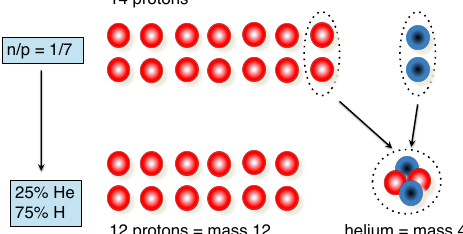
Figure 1: Left: The observed nearly 25% of helium and 75% of hydrogen in the universe can be understood if the neutron to proton ratio during the Big Bang nucleosynthe- sis was equal to n / p = 1 /